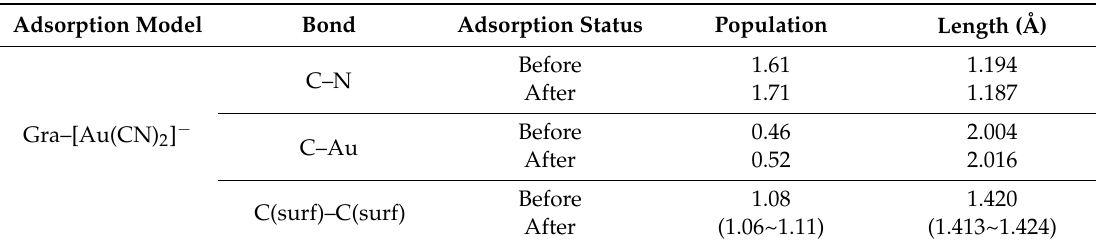
Table 2. Mulliken bonding population of atoms before and after [Au(CN) 2 ] − adsorption to the graphite (0001)